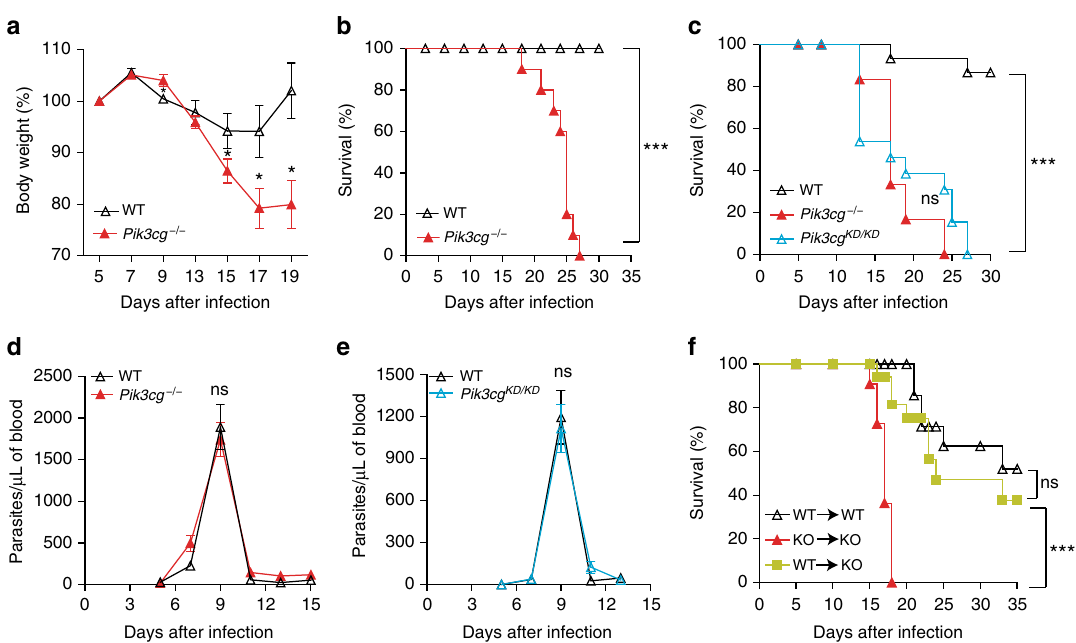
Fig. 2 PI3K γ signaling in hematopoietic cells is essential for mouse resistance to T . cruzi infection. a – c Body weight ( a ) and survival rate of C57BL/6 WT ( n = 10) and Pik3cg − / − ( n = 10) ( b ) or Pik3cg KD/KD ( n = 10) ( c ) mice infected with 10 3 trypomastigote forms of T . cruzi Y strain. d , e Blood parasitemia of WT and Pik3cg − / − ( d ) or Pik3cg KD/KD ( e ) mice infected with 10 3 trypomastigote forms of T . cruzi Y strain. f Survival rate of chimera mice infected with 500 trypomastigote forms of T . cruzi Y strain. * P < 0.05, *** P < 0.001, and ns = no statistical signi fi cance (unpaired Student ’ s t -test in a , d , e and Mantel – Cox log-rank test in b , c , f ). Data are representative of two ( f ) of three ( a – e ) independent experiments (mean ± s.e.m in a , d , e